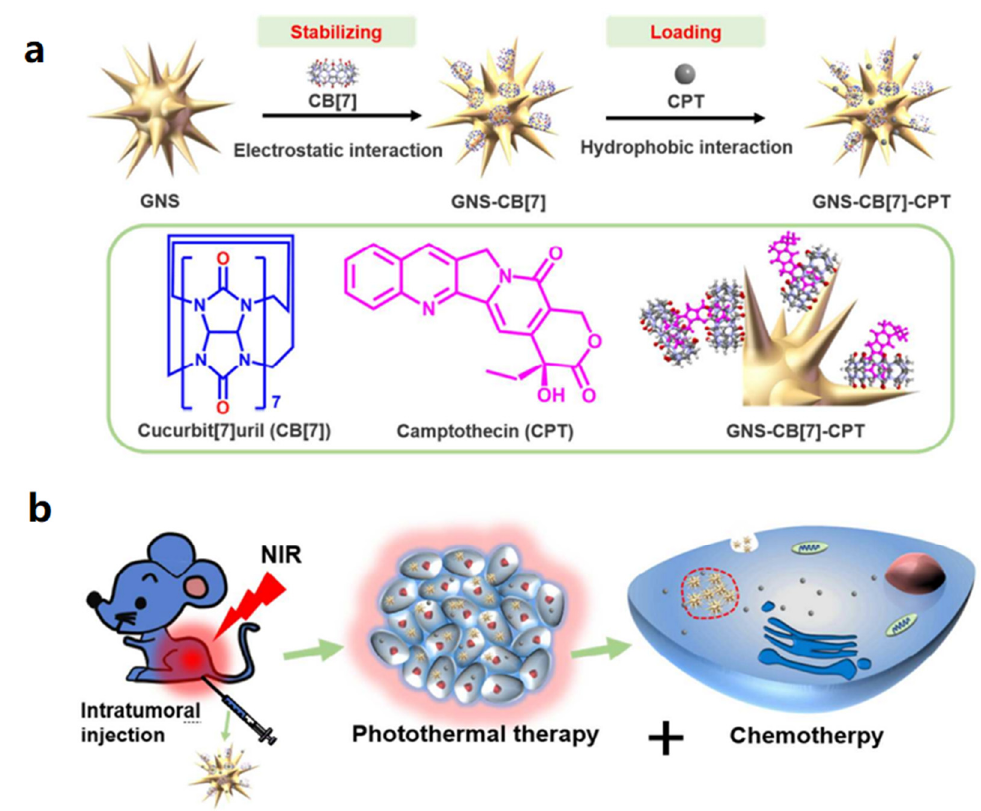
Figure 24. Diagram of ( a ) the synthesis process of GNS-CB[7]-CPT. ( b ) Pharmacokinetics and pho- tothermal treatment (reproduced with permission of American Chemical Society from ref. [102]).